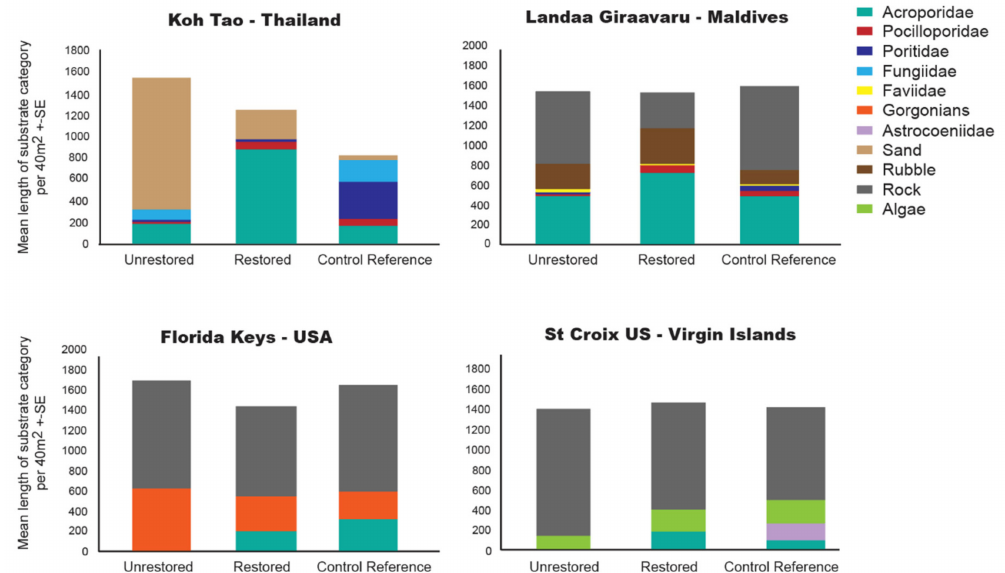
Figure 10. Comparisons of the mean cover of the most influential substrate categories (post-simper analyses) per 40-m 2 belt transect among treatments (unrestored, restored, reference control sites) at each of the four locations. n = 9 transects per treatment in Koh Tao, Landaa Giraavaru, and the Florida Keys; In St Croix, n = 8 transects for unrestored and restored treatments, n = 6 transects for the control reference